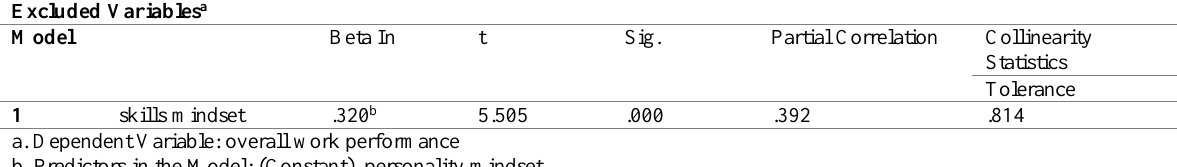
Table 12(d): Collinearity Statistics